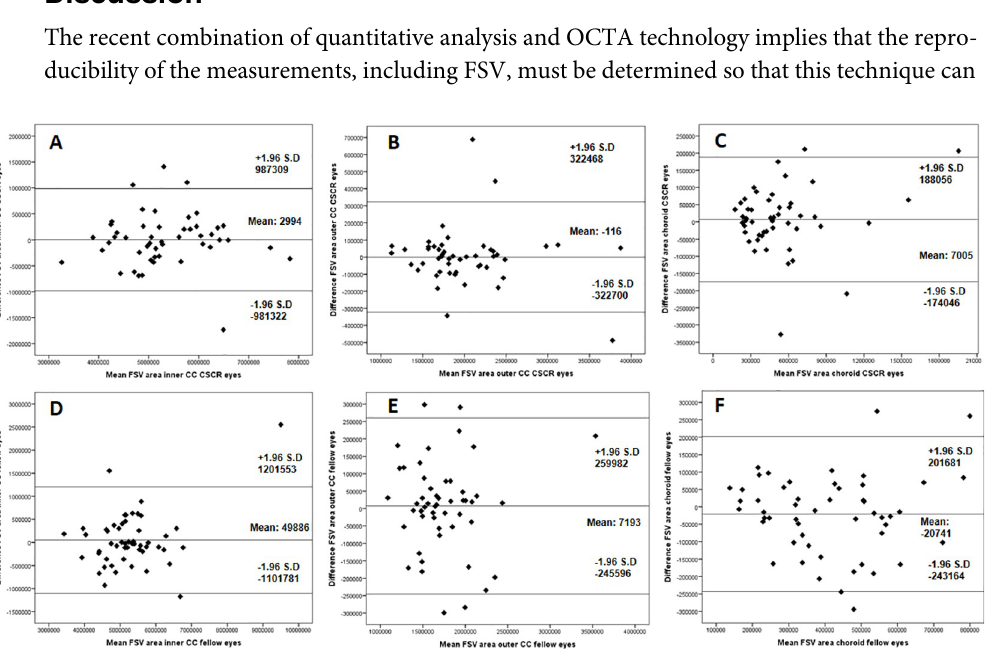
Fig 5. Bland-Altman plots showing the flow signal voids (FSV) area in the different segmentations studied (A and D: inner choriocapillaris (CC) in CSCR and fellow eyes respectively; B and E: outer CC in CSCR and fellow eyes respectively, C and F: choroid in CSCR and fellow eyes